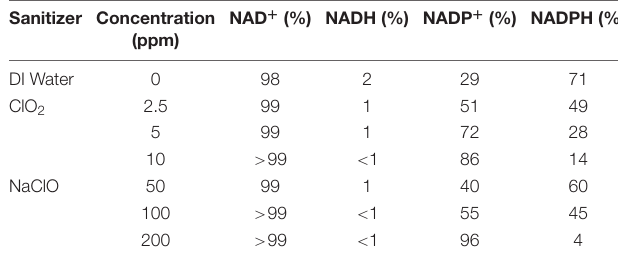
TABLE 2 | The average percentage of reduced or oxidized forms of NAD + / NADH or NADP + /NADPH were measured after treatment with ClO 2 or NaClO. Sanitizer Concentration